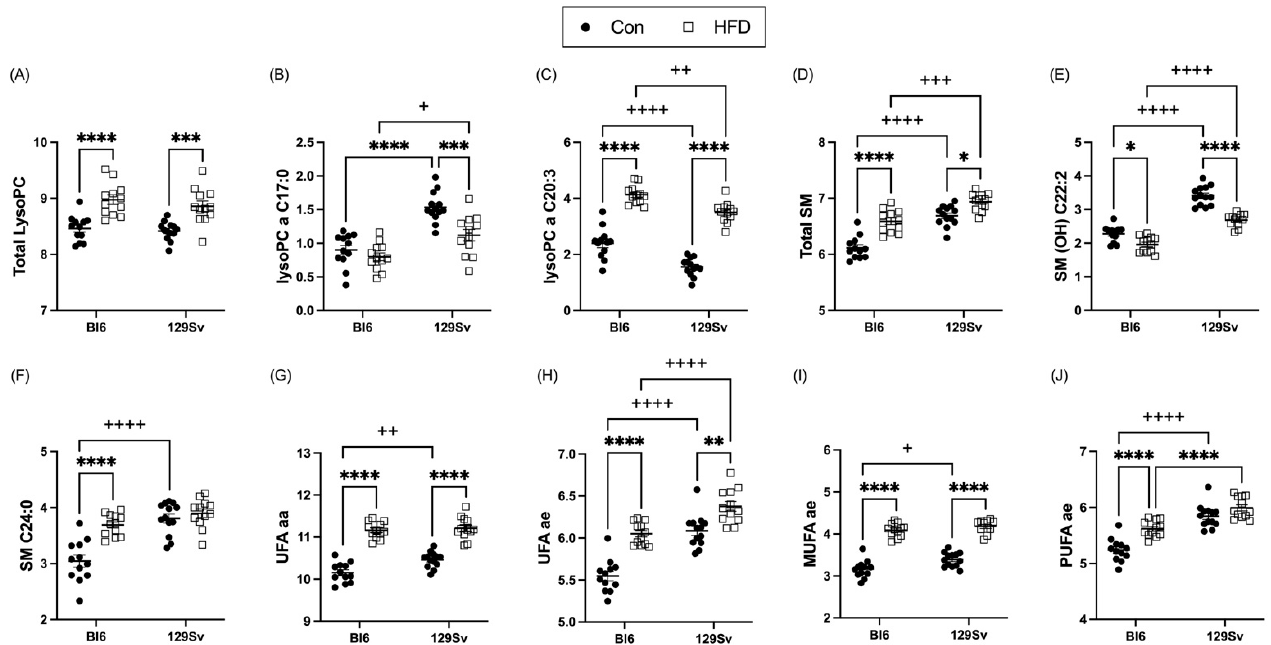
Figure 6. Effect of HFD on the level of selected lipids (Log2 values, data expressed as mean ± SEM). ( A ) sum of lysoPCs, ( B ) lysoPC a C17:0, ( C ) lysoPC a C20:3, ( D ) sum of sphingomyelins, ( E ) SM (OH) C22:2, ( F ) SM C24:0, unsaturated (UFA) PC aas, ( G ) and PC aes ( H ), ( I ) monounsaturated fatty